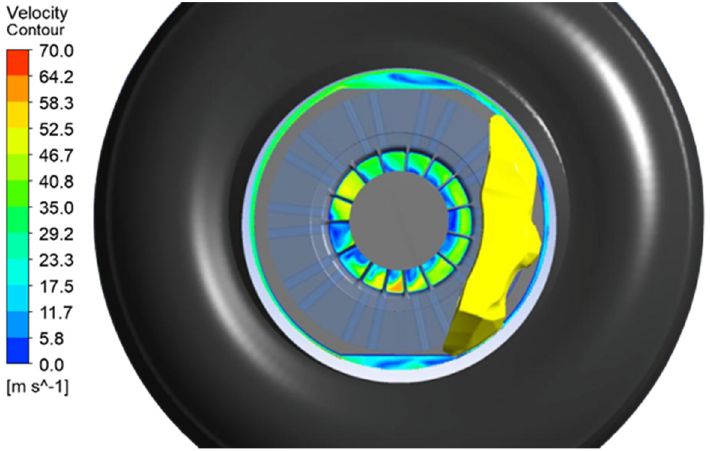
Figure 10. Velocity contours on plane Y2, with flow separations on the distributor vanes.